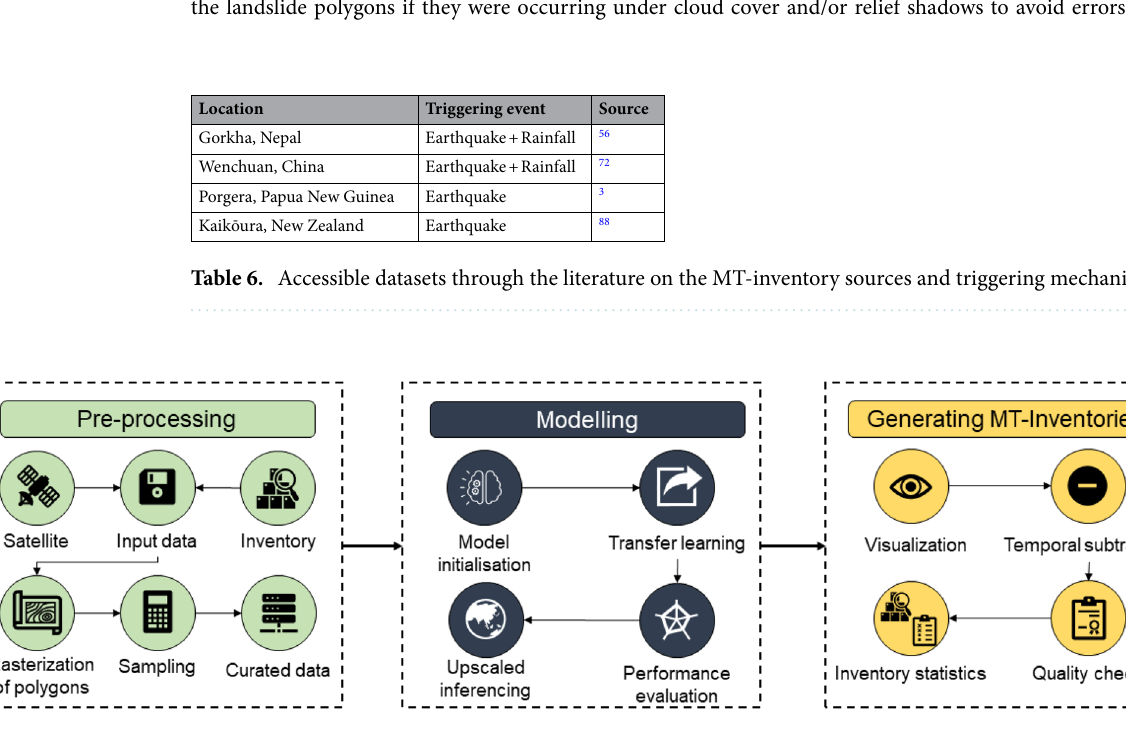
Figure 12. Conceptual framework of the automatic MT landslide mapping method based on deep transfer